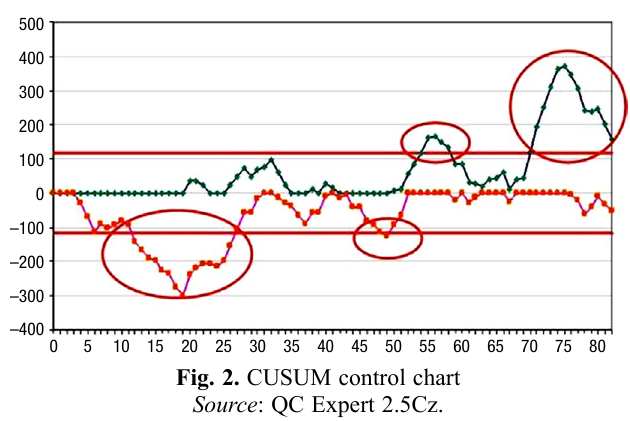
Fig. 1. Shewhart´s control chart Source: QC Expert 2.5Cz.